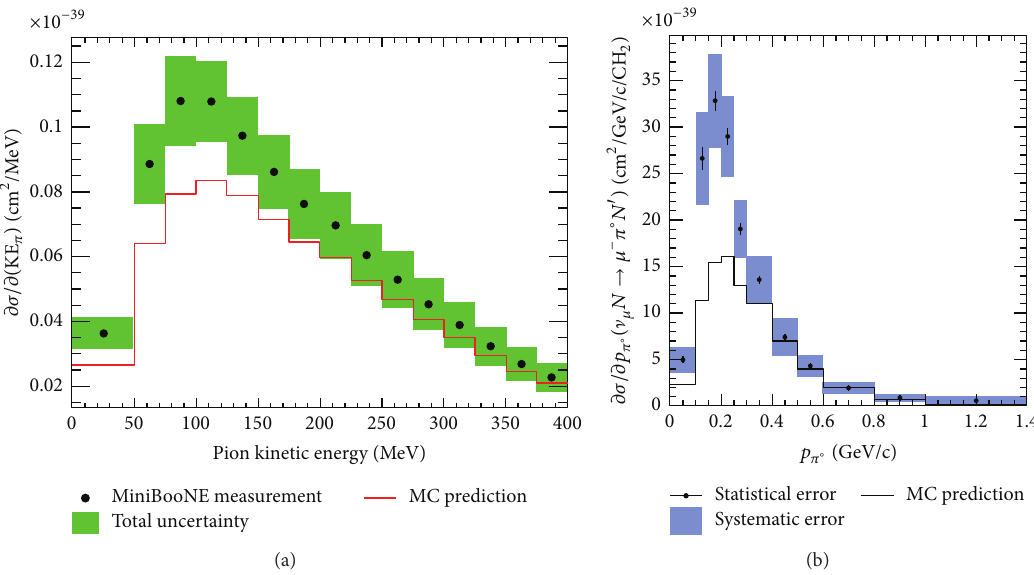
Figure 4: (Color online) MiniBooNE single pion production results. (a) is 𝜋 + kinetic energy differential cross section from CC1 𝜋 + interaction on CH 2 [8]. (b) is 𝜋 ∘ momentum differential cross section from CC1 𝜋 ∘ interaction in CH 2 [9]. As you see, predictions underestimate data for both channels and the shapes do not agree as